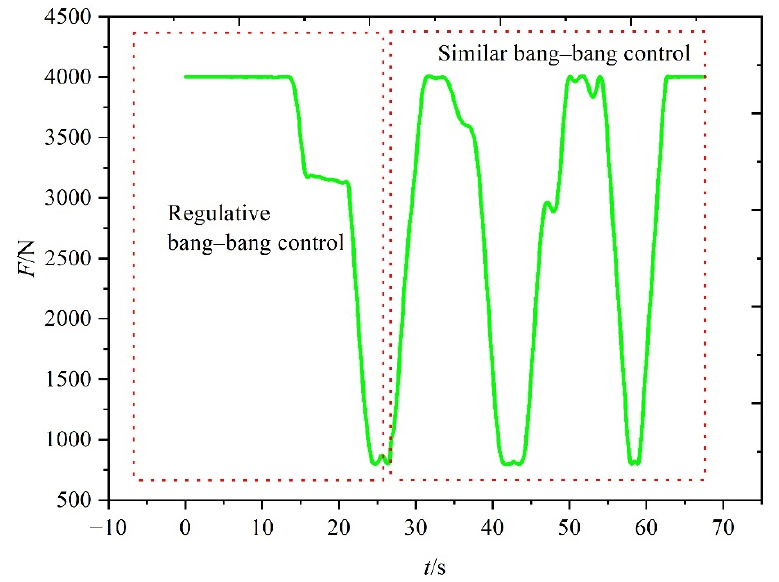
Figure 11. Thrust in the second scenario vs. time.